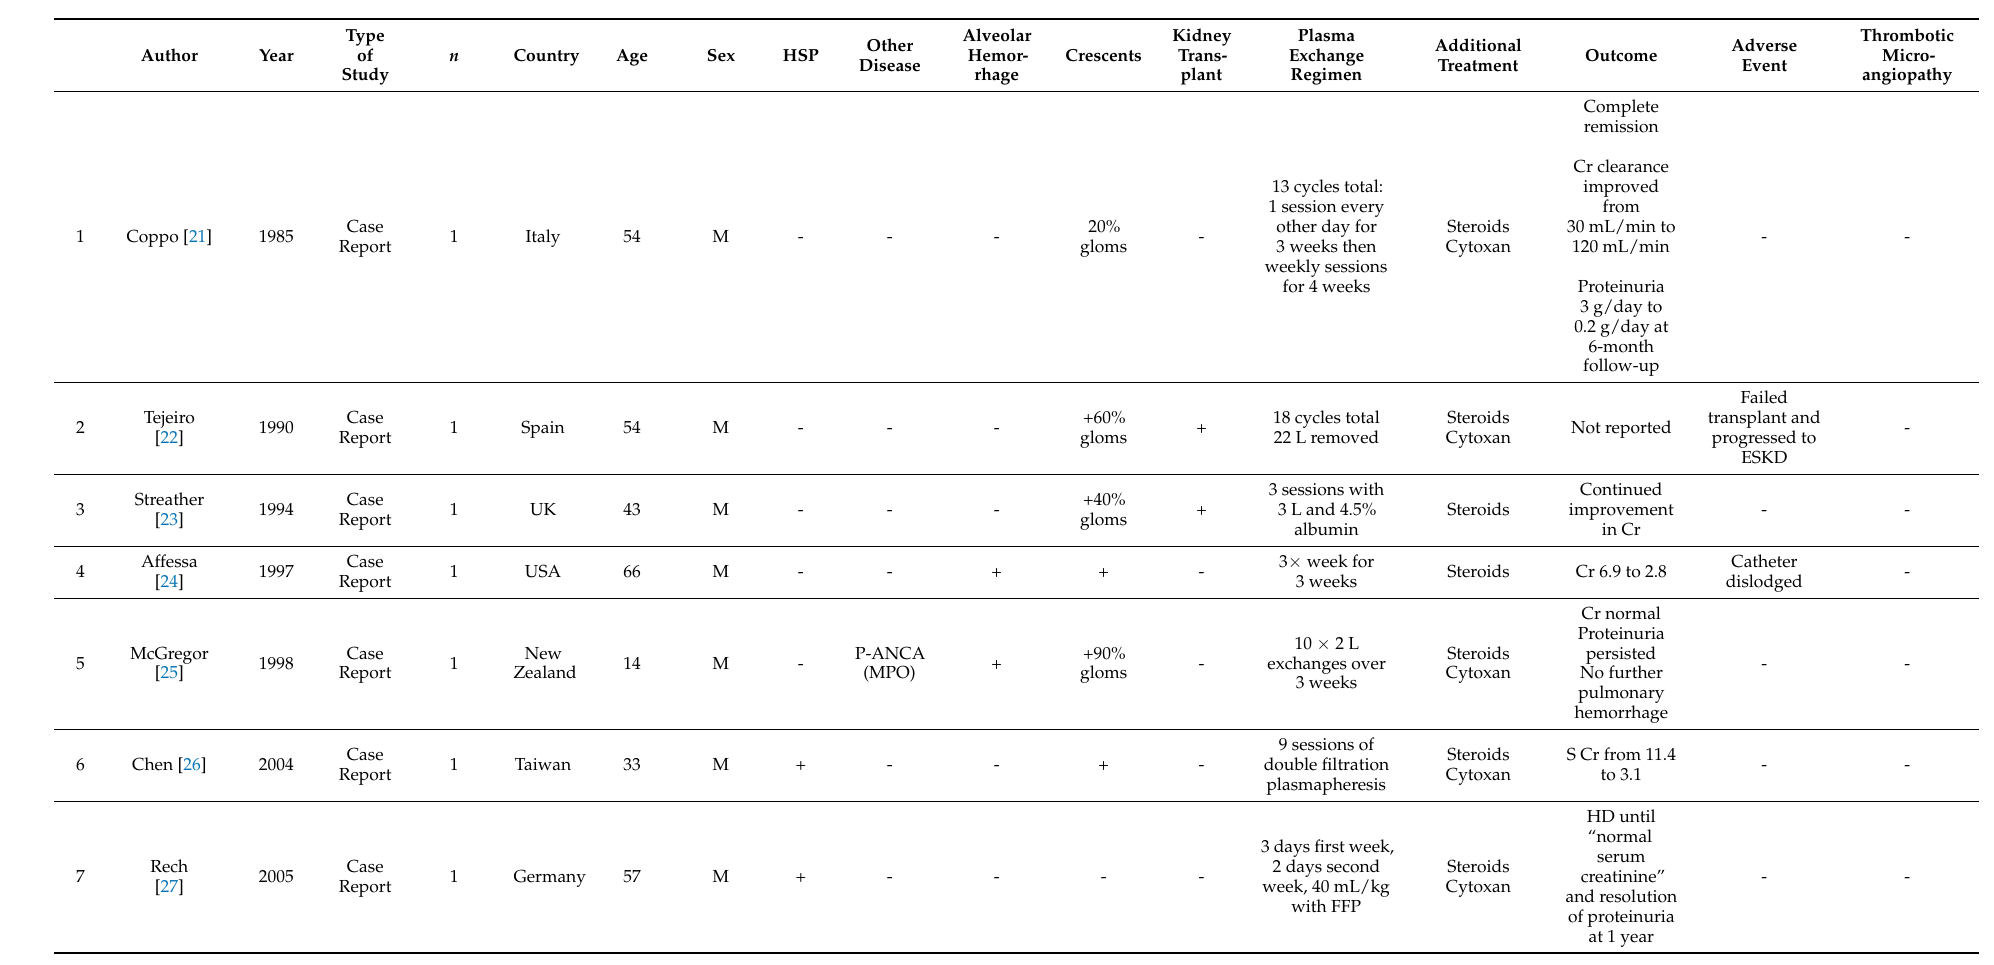
Table 1. Characteristics of included case